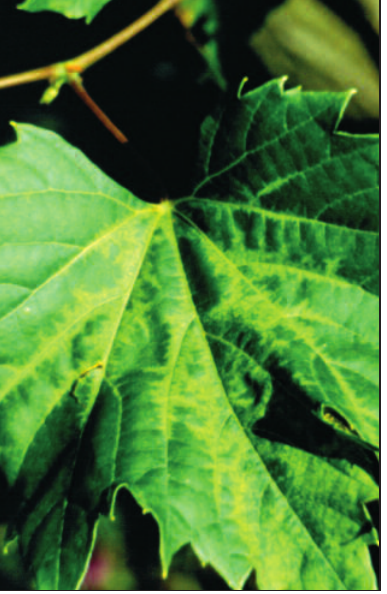
Figure 20. Vein necrosis (GVN) – 110R indicator shows necrosis of the veinlets on the underside of the leaf blade